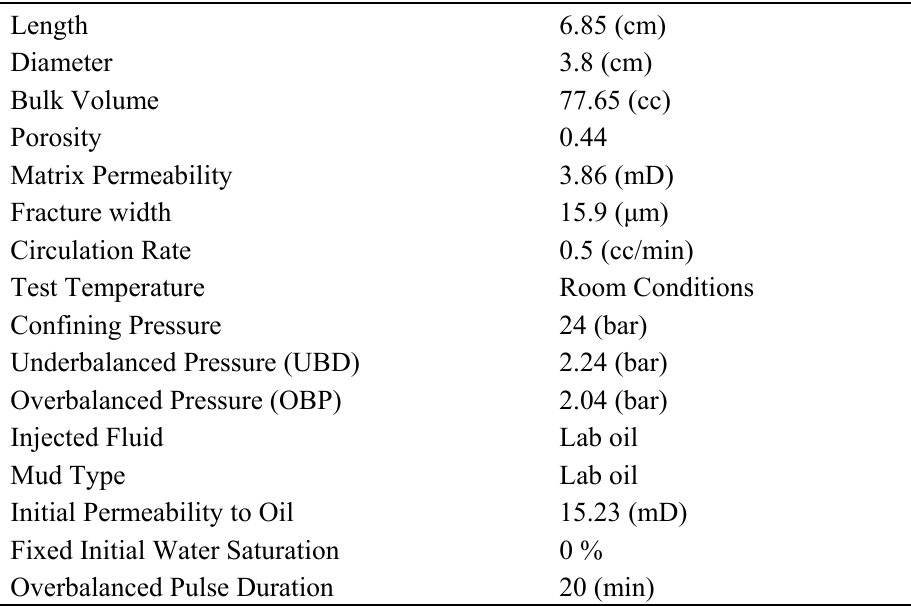
Table 2. UBD leak-off test with lab oil; Sample A.